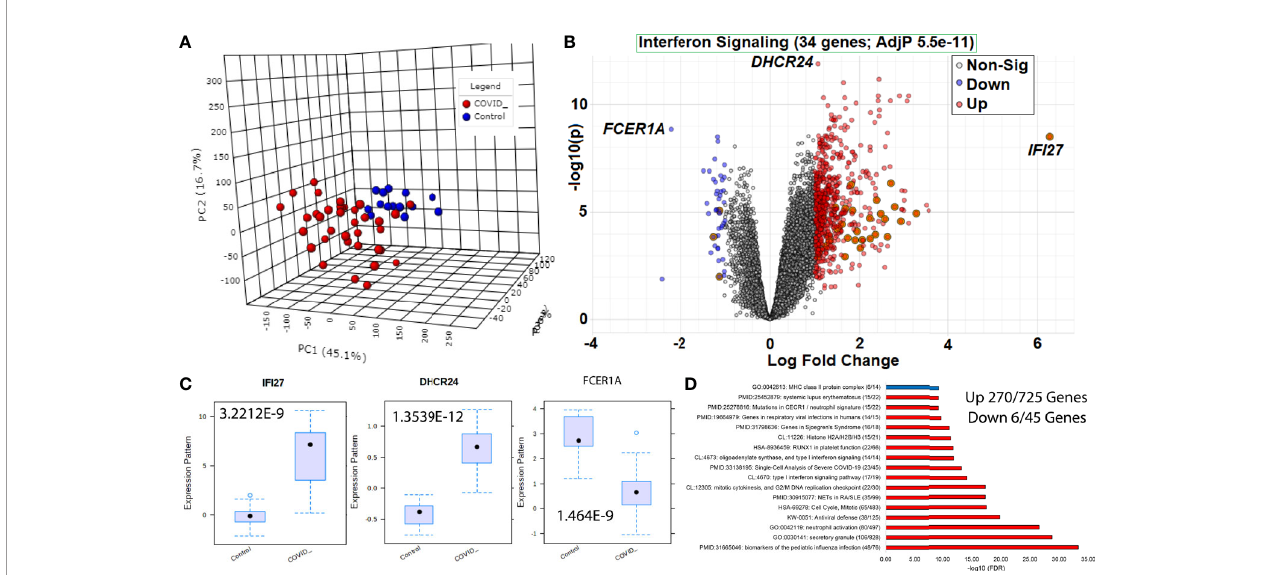
FIGURE 2 | Blood transcriptome gene signatures of SARS-CoV-2 patients. (A) Three dimensions of principal components (PC1-PC3) of fi rst collection time point RNAseq gene annotations for samples of COVID-19 (red) or control (blue) patients. (B) Volcano plot of gene expression in COVID-19 or control patients with signi fi cant genes higher (red) or lower (blue) marked. The x-axis shows the log2 fold change, and the y-axis shows the -log10 of the adjusted p-value. Shadowed genes are involved in interferon signaling. (C) Box and whisker plot of the top three genes labeled in panel (B, D) Top gene ontology (GO) enrichment terms for up (red) or down (blue) genes. The term for each enriched description is shown fi rst, followed by the name, and then in parentheses, the number of genes is signi fi cant relative to the number of genes within the genome annotated for the term. The x-axis shows the -log10 of the false discovery rate